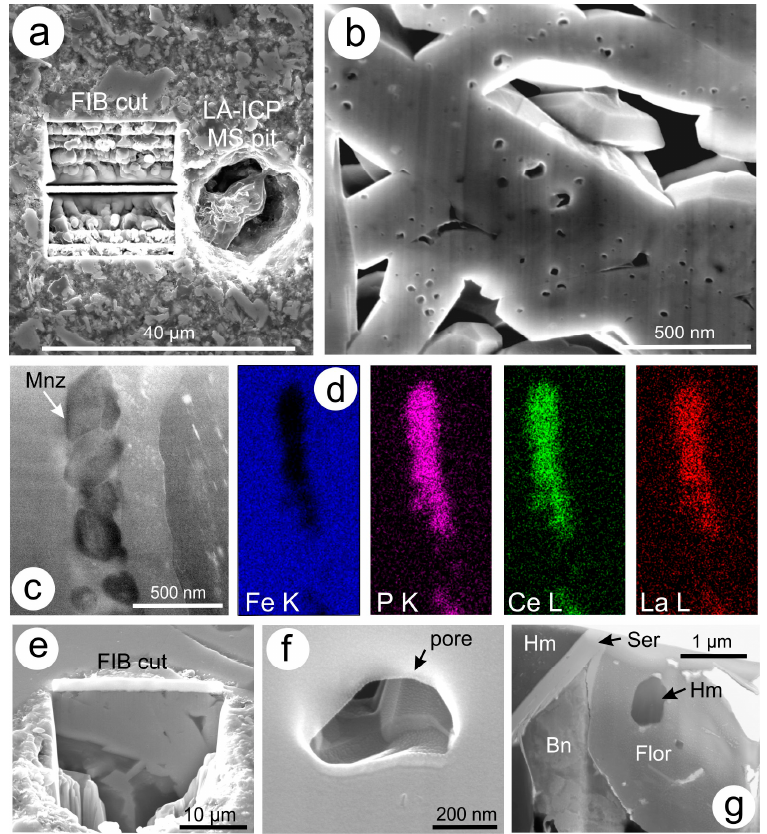
Figure 3. Mineral inclusions and porosity present in hematite from samples shown in Figure 2a,b SE images showing location of FIB ‐ cut next to LA ‐ ICP ‐ MS spot in rusty hematite ( a ); and the presence of pores and inclusions within the sub ‐ µm size lamellae ( b ); ( c ) FIB ‐ Scanning Transmission Electron Image in Bright Field mode showing trails of sub ‐ µm inclusions of monazite (Mnz) close to the grain boundary; ( d ) FIB ‐ EDS maps of monazite grains in (c); ( e , f ) SE images showing distribution of pores and their morphology in hematite from (c) obtained after FIB ‐ cross sectioning through the polished block; ( g ) Sub ‐ µm ‐ sized inclusion of hematite (Hm) in florencite (Flor) from a high ‐ grade bornite (Bn) ‐ bearing sample at OD. Ser—sericite.